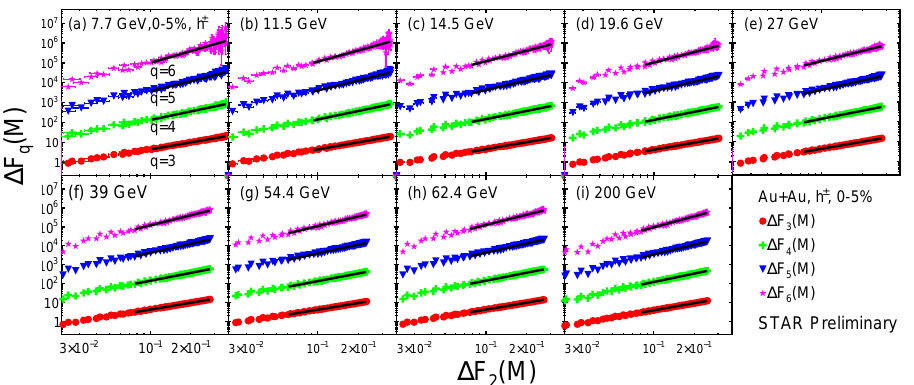
( M ) (q = 3-6) as a function of ∆ F Figure 2: ∆ F q (cid:112) + Au collisions at = 7.7-200 GeV in double-logarithmic s NN